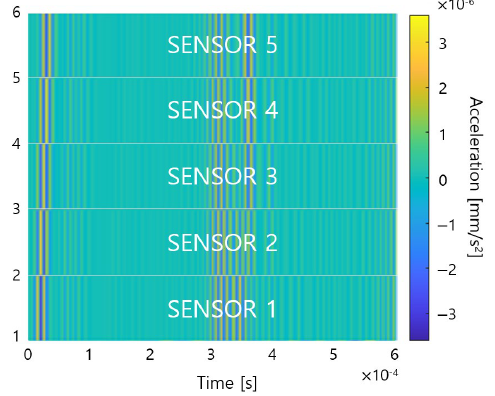
Figure 4. Example of converted image for training.